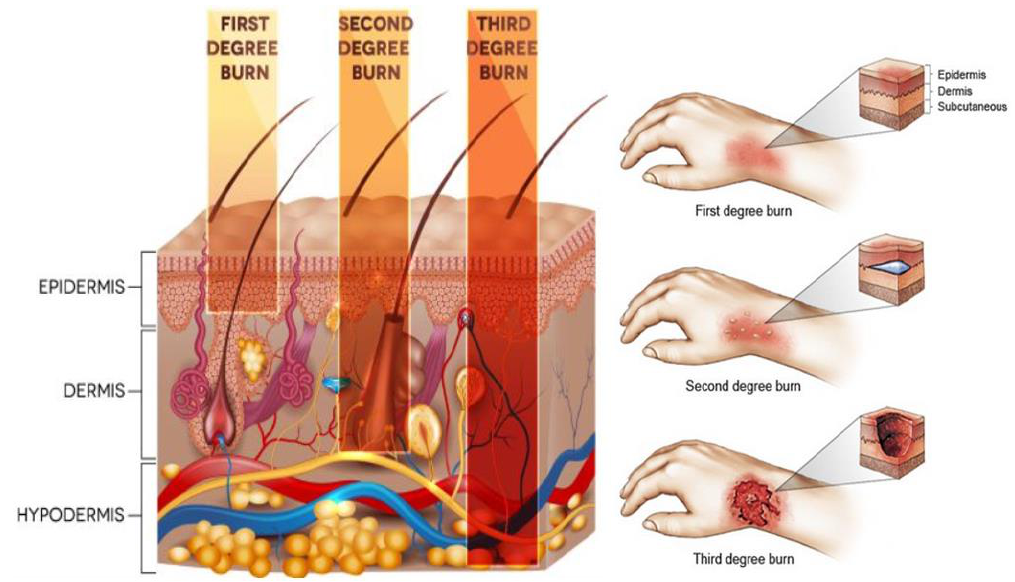
Figure 1. Illustration of different depth of invasion for burn injury [4,5].